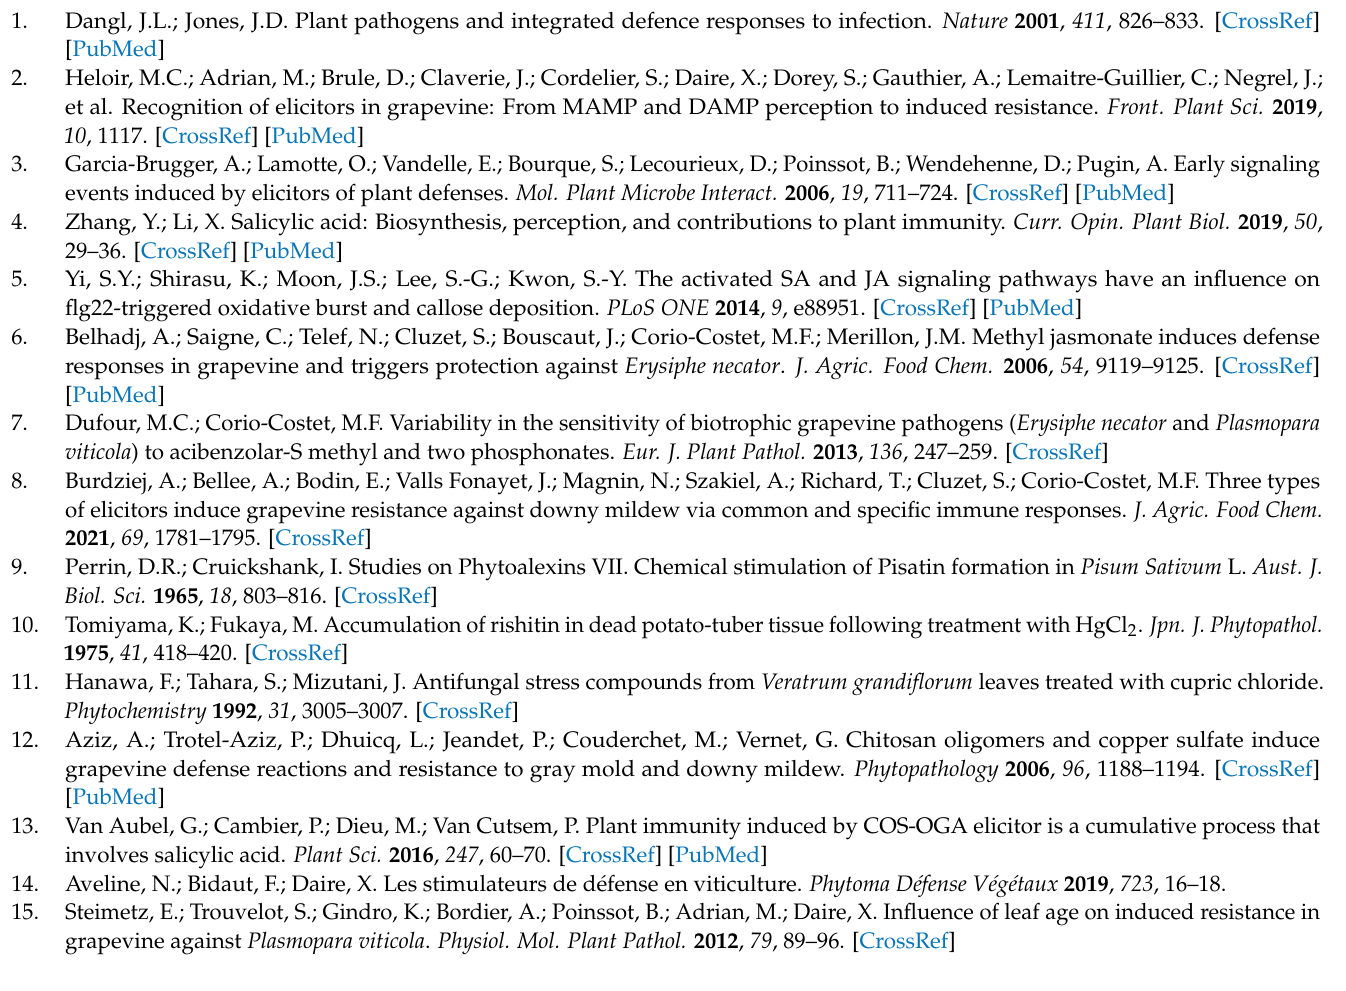
vineyards.; Table S2. List and details of samples collected along the 3 years experiments in Burgundy (cv. Chardonnay) and Bordeaux (cv. Cabernet franc) vineyards, respectively; Table S3. List of VOC standards used in GCMS